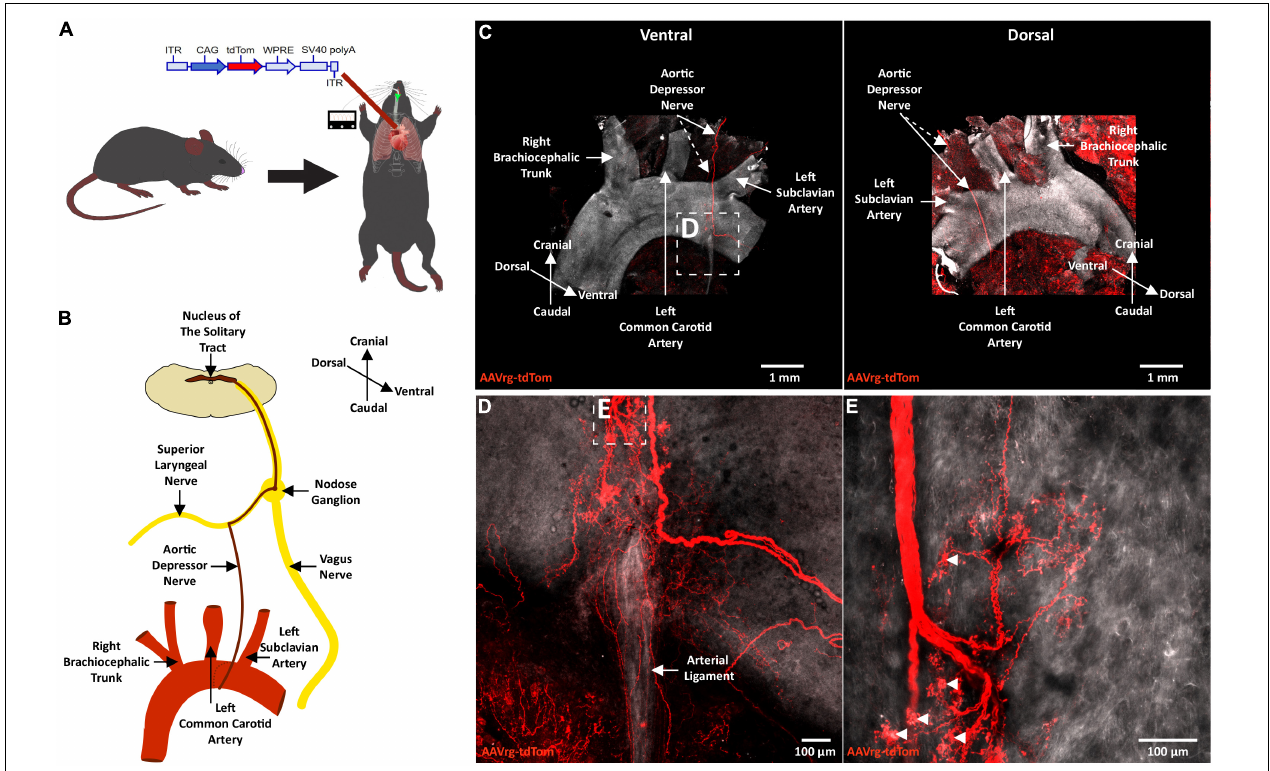
FIGURE 1 | Terminals of sensory neurons innervating the aortic arch are selectively labeled with a retrograde adeno-associated viral vector. (A) A schematic diagram depicting the cardiothoracic surgery performed to allow for the application of an AAVrg to the aortic arch to direct the expression of tdTom within the sensory neurons innervating the aortic arch ( n = 4). (B) A schematic demonstrating the sensory innervation of the aortic arch. (C) A representative photomicrograph of a whole-mount aortic arch showing selective expression of tdTom in the sensory nerve terminals innervating the aortic arch ventrally (left) and dorsally (right). (D,E) Higher magnification scans revealing the morphology of the sensory nerve terminals innervating the aortic